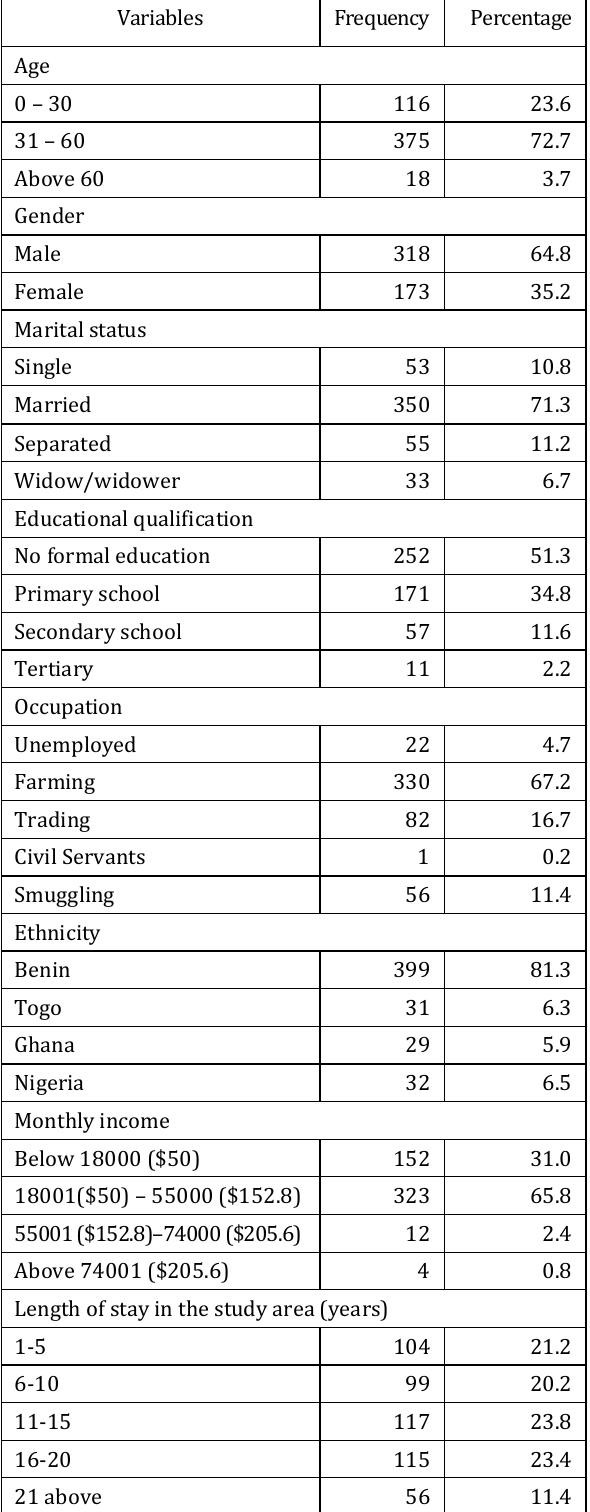
Table 1. Socio-economic characteristics of the